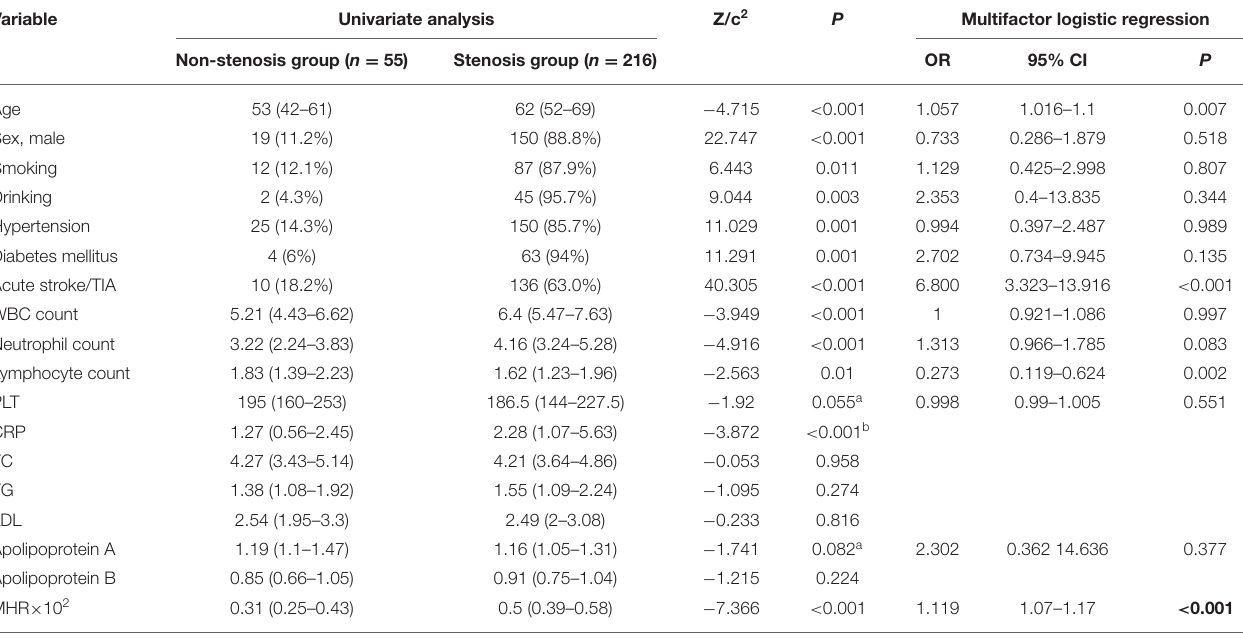
TABLE 1 | Comparison of factors between the non-stenosis group and the atherosclerotic stenosis group. Variable Univariate analysis